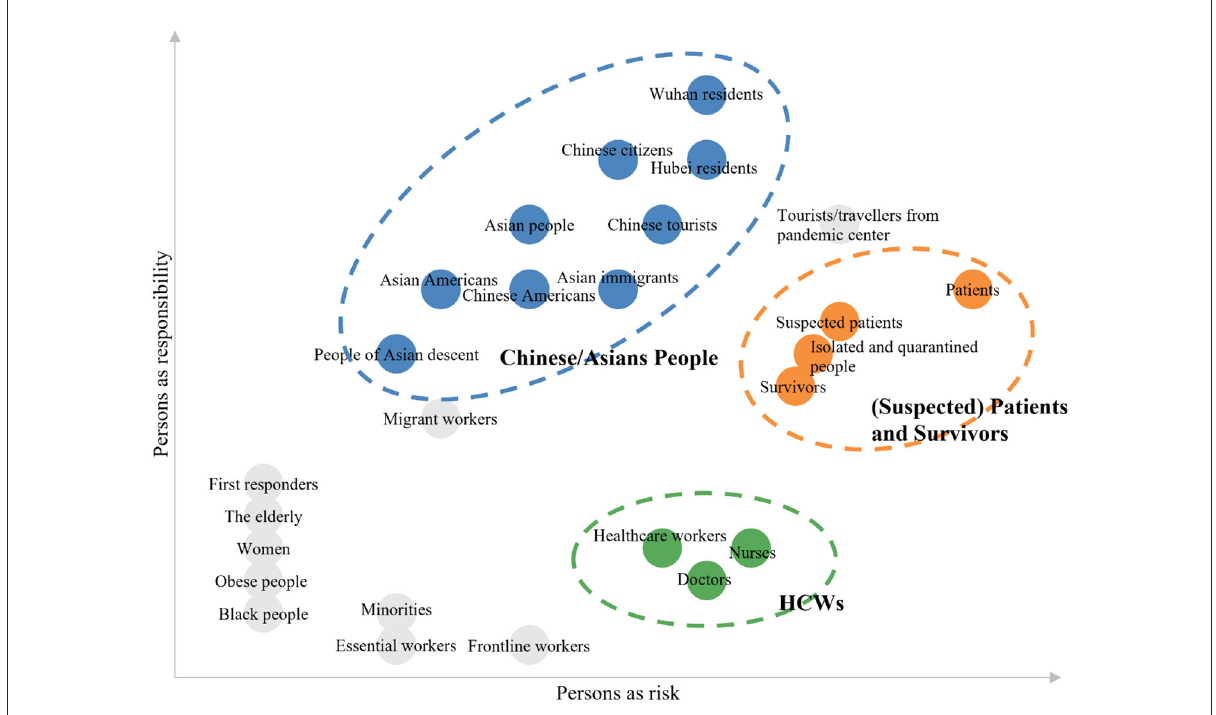
FIGURE2 Summary of stigma targets during the COVID-19